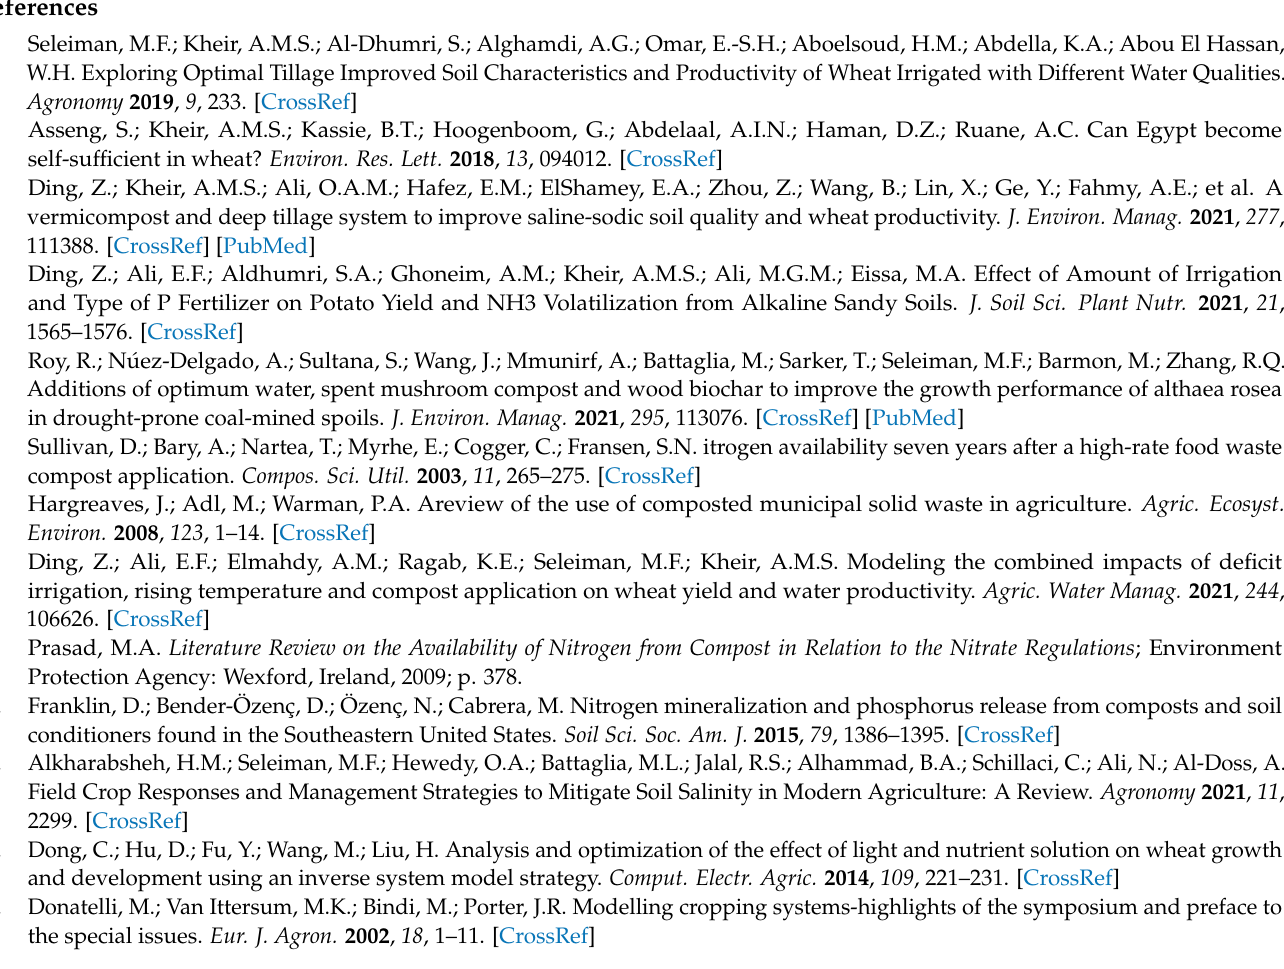
from compost (A) and both compost and mineral nitrogen fertilization (B) under different treatments; Figure S10. Effects of irrigation, fertilization, and planting dates on Wheat WP (data represent the average of both seasons); Figure S11. Wheat water applied (a), use (b), stored(c) and application efficiency (d) as affected by irrigation and planting dates; Table S1 Soil physical properties of the studied soils before treatment application; Table S2 Soil chemical properties of the studied soils before treatment application; Table S3 The detailed chemical and nutritional analysis of the used compost, according to [28]; Table S4 Main effects of planting dates, irrigation and fertilization on wheat grain and biomass yields (data represent the average of two